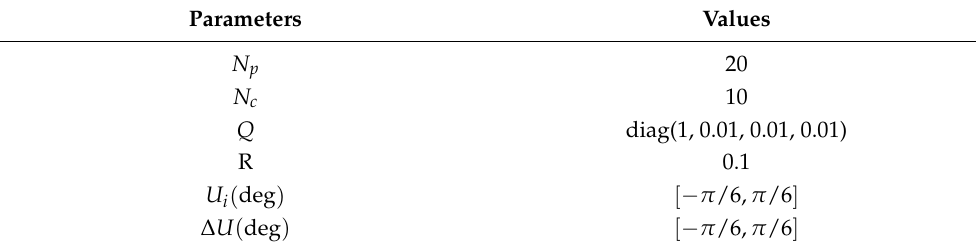
Table 1. Parameters of